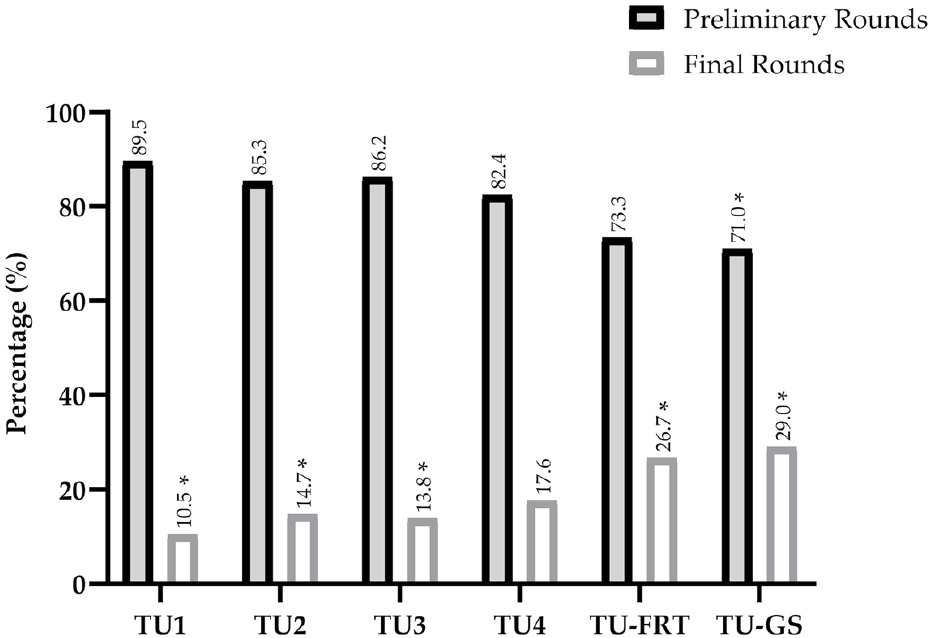
Figure 1. Descriptive analysis and associations between temporal units (TUs) and grouped rounds (preliminary and final rounds, PRs and FRs, respectively) (n = 2340). Asterisk highlights the variables leading to the most important contributions to the difference, according to the SR; SRs = standardised